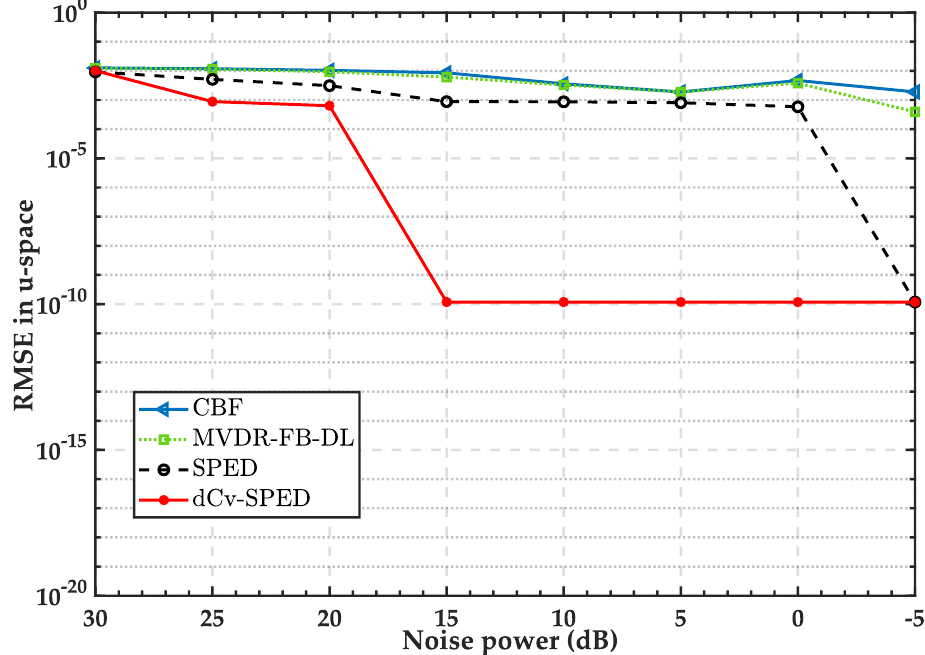
Figure 8. Root mean square errors of the estimated direction in the u-space vs. noise power for the CBF, SPED, MVDR-FB-FL, and dCv-SPED under array perturbations.